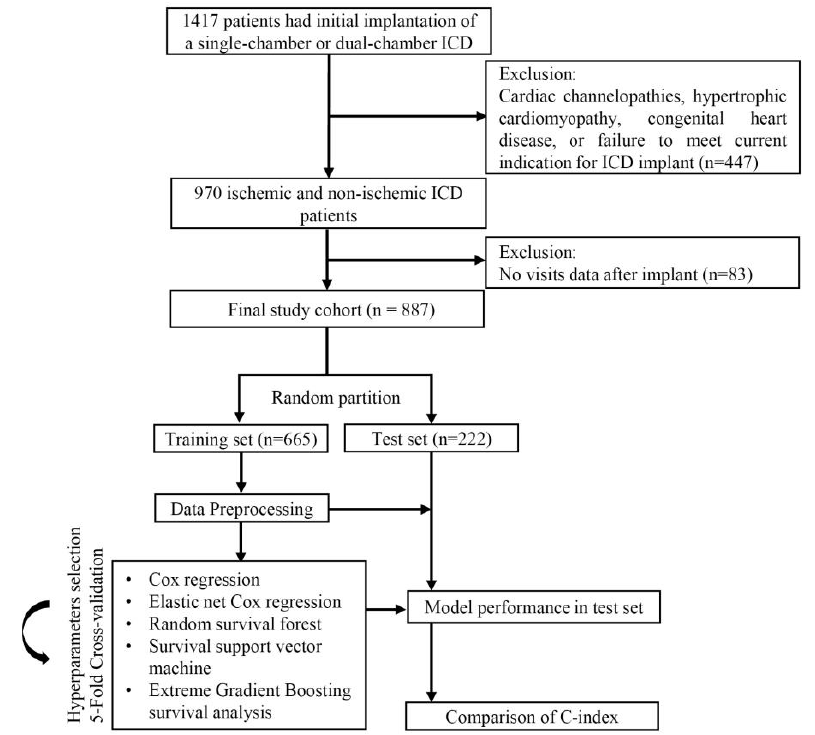
Figure 1. Study flow diagram. ICD, implantable cardioverter defibrillation.